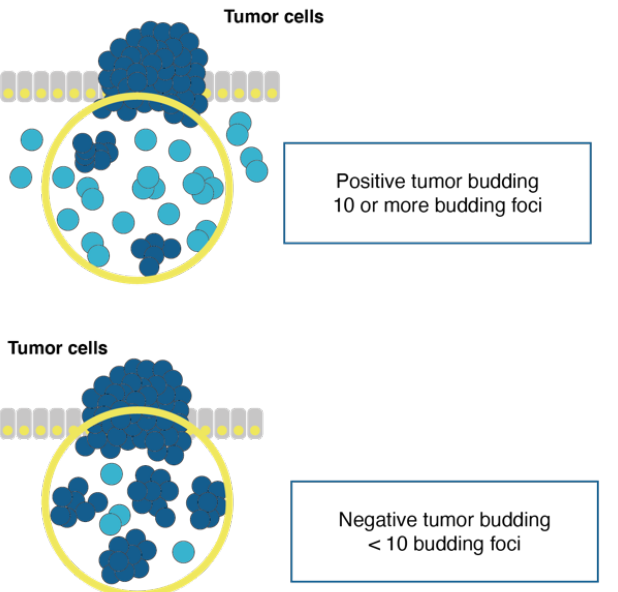
Figure 2. Schema of tumor budding. The circle represents an area of magnification, showing ≥10 (positive) or <10 (negative) budding foci of isolated single cancer cells or a cluster composed by a few cancer cells (modified from Fukumoto et al. [21]).